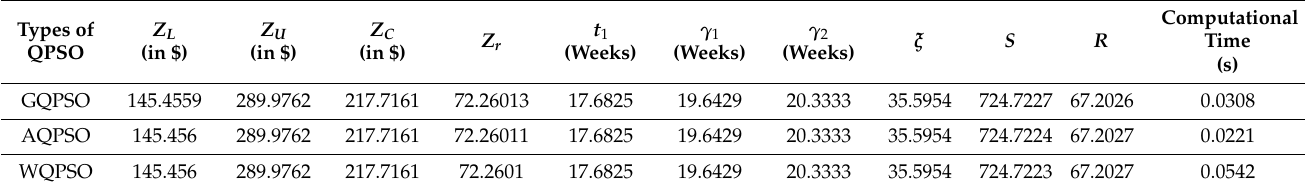
Table 2. Best found results for Case-I of Example 1.